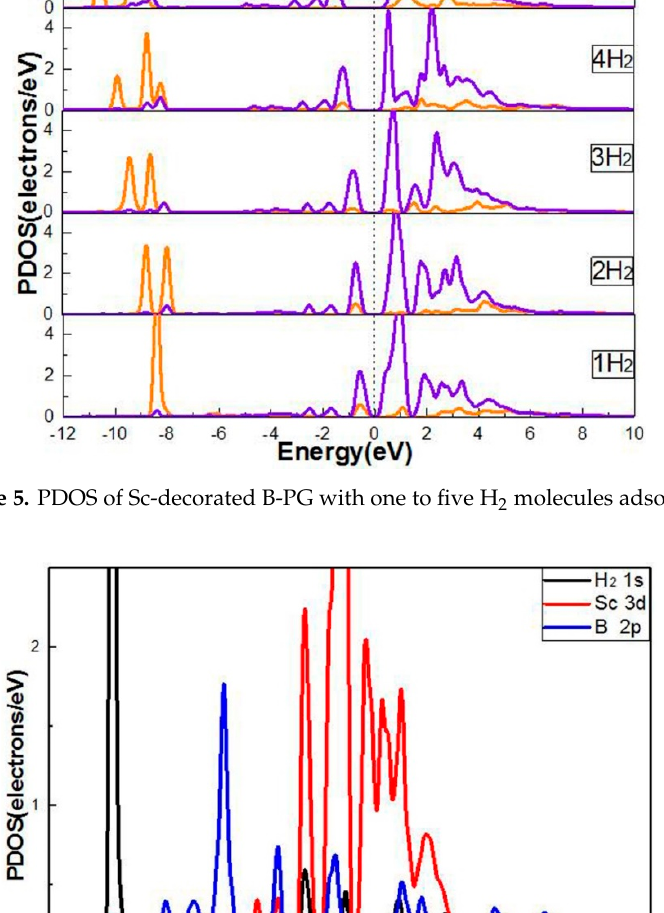
Figure 5. PDOS of Sc-decorated B-PG with one to five H 2 molecules adsorbed.